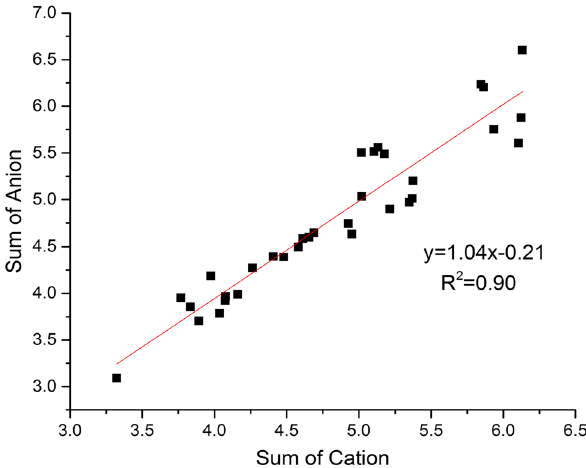
Fig. 6 CBE plot of water samples for premonsoon season